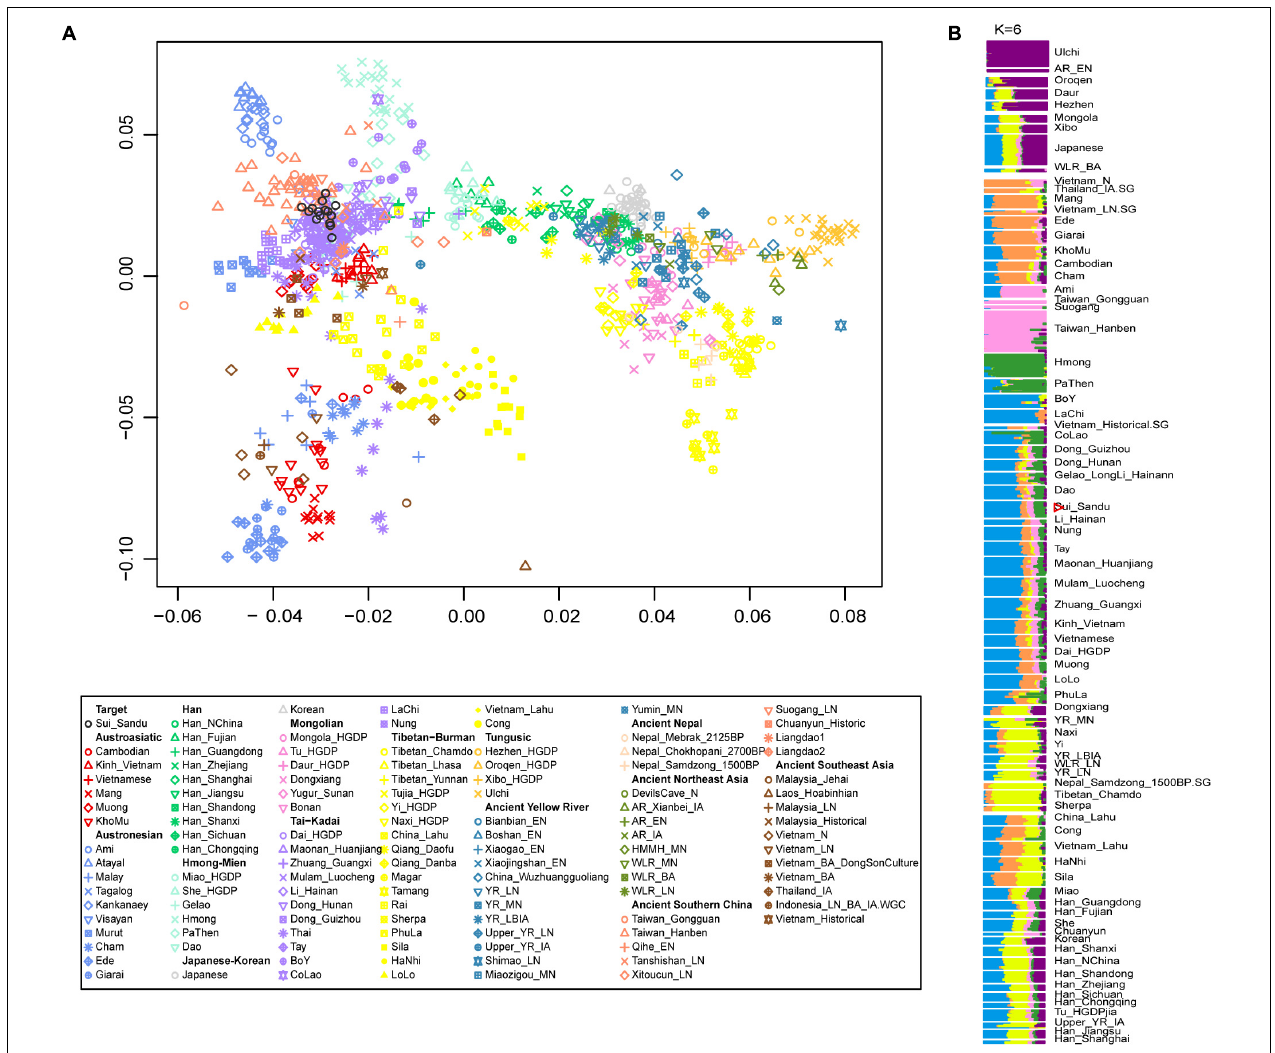
FIGURE 3 | The population structure of modern and ancient populations in Asia based on genome-wide data. (A) PCA results showed an overview population relationship between modern populations and ancient populations. (B) ADMIXTURE results (the lowest CV errors K = 6): ancestral components among Guizhou Sui and modern and ancient populations in